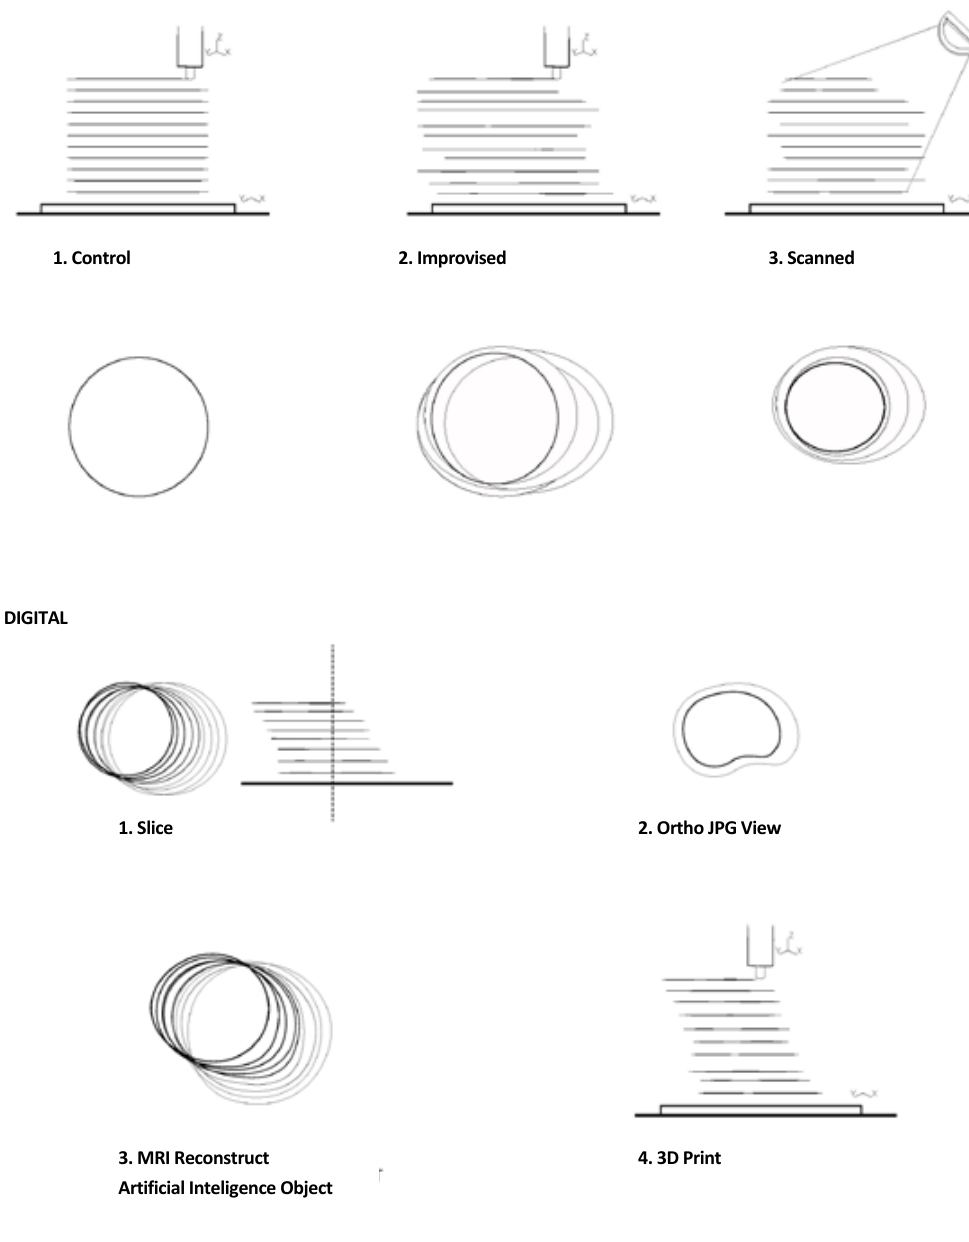
Figure 6 (top): Primary steps in the process to create AI artefacts. Source: